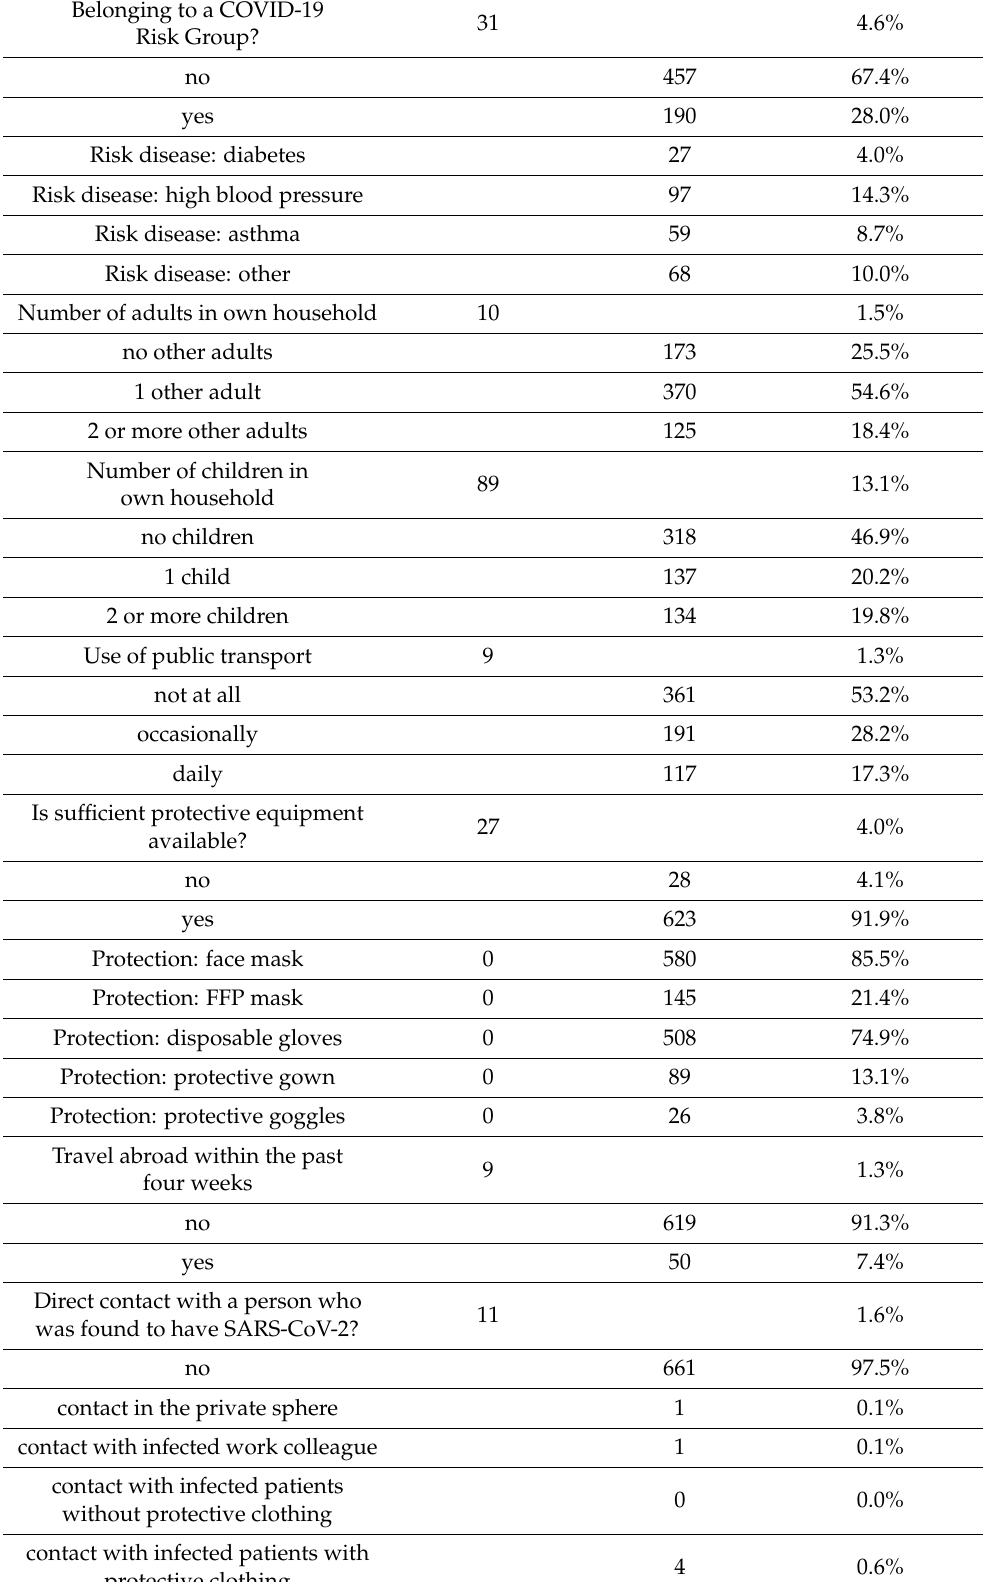
Table 2. Possible risk factors for a SARS-CoV-2